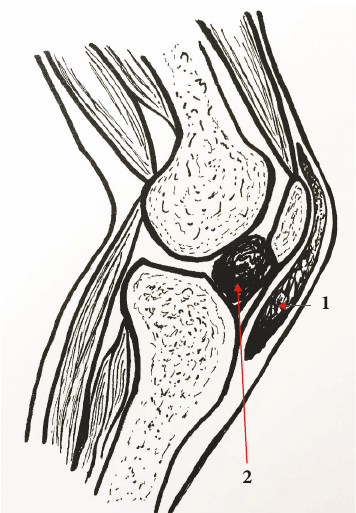
Figure 1: Inclusion criteria of the patients according to the tumor localization. Schematic illustration of a knee joint (lateral view). The patients were divided into 2 groups according the tumor localization. Patients with a superficially spreading lesion and no joint involvement were included in this study (indicated as number 1). If the tumor site is deep and involves the joint space (indicated as number 2) an extra-articular resection of the knee was